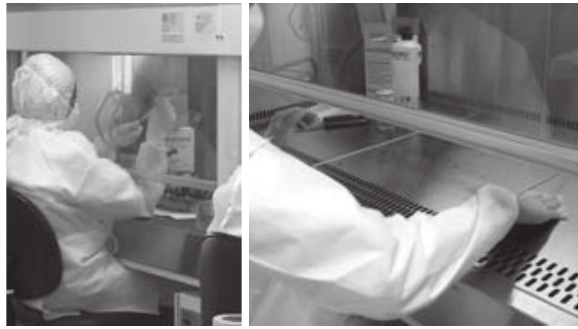
Figura 2 – Técnico realizando o procedimento de ANT (A) e procedimento de limpeza com álcool a 70% após o término das atividades (B)